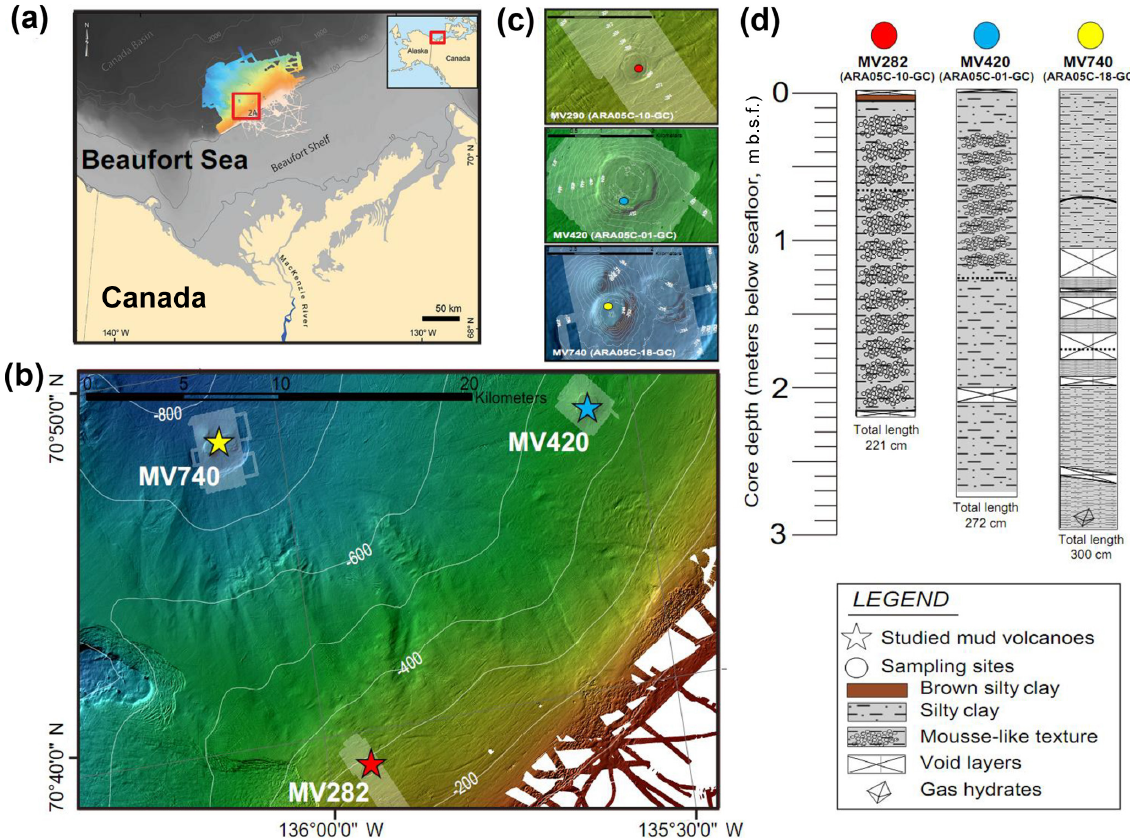
Figure 1. (a) Map showing the study area (red box) with inset regional map of Alaska and northwestern Canada modified from Paull et al. (2015). (b) Map showing the three mud volcano (MV) locations on the upper slope of the Beaufort Sea. (c) Detailed bathymetric maps showing the locations of sediment cores ARA05C-10-GC (MV282), ARA05C-01-GC (MV420), and ARA05C-18-GC (MV740). (d) Lithology of the three sediment cores